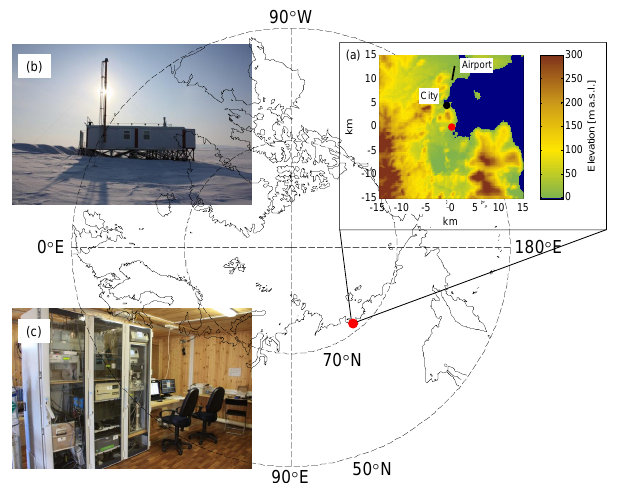
Figure 1. Location of the Tiksi measurement station. Panel (a) : to- pographic map (United States Geological Survey, 2015 1 ) of the sur- roundings of the measurement site (station indicated by a red dot). Panel (b) : the station as seen from outside. Panel (c) : the station